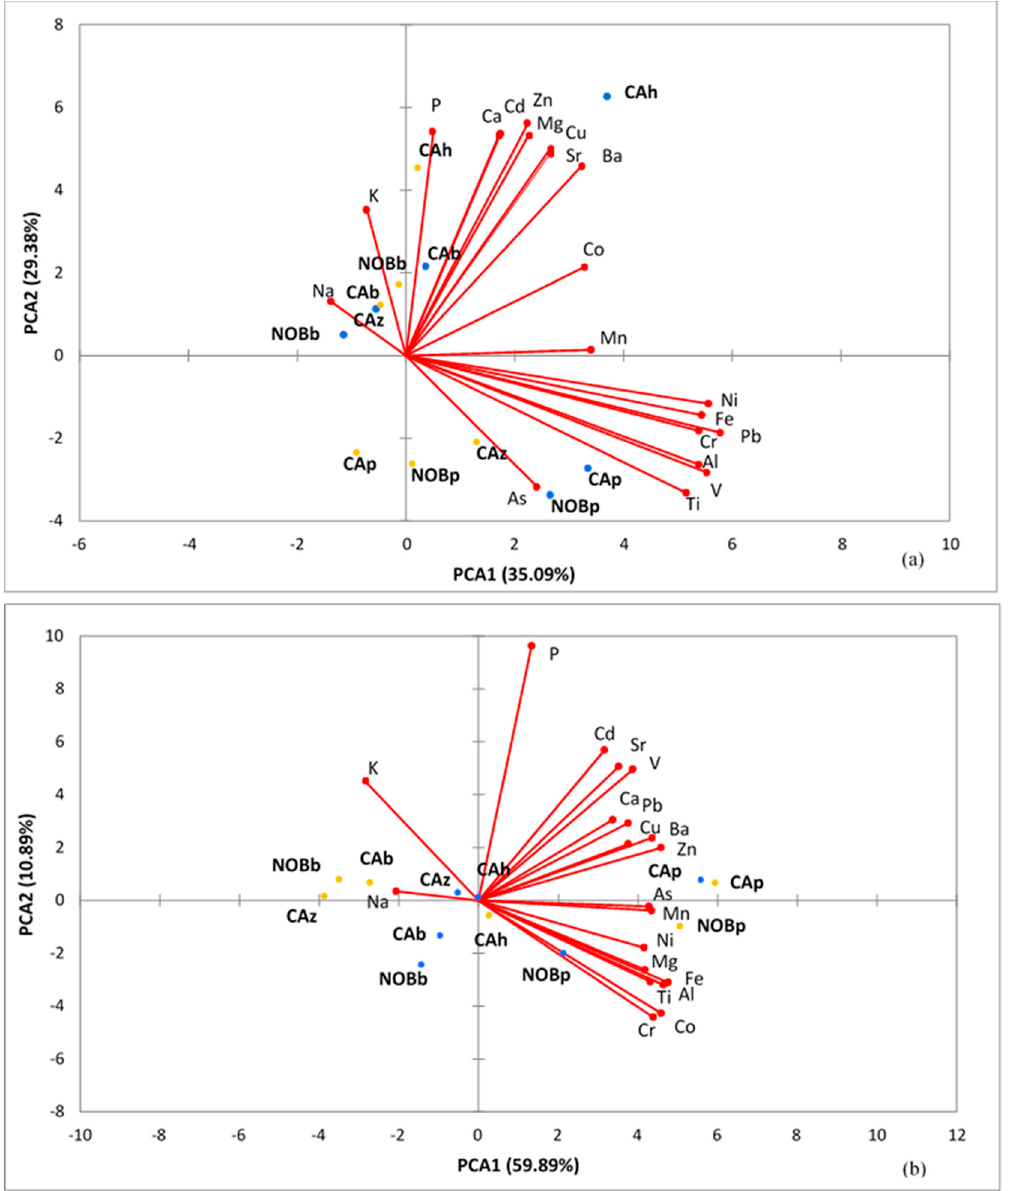
Figure 2. Score and loading plot from principal component analysis (PCA) (PC1 vs. PC2) on element concentration data of ( a ) epigeal and ( b ) hypogeal parts. NOB = plants grown in Nobile soil, CA = plants grown in Campana soil, yellow spot = addition of FW to the soil, blue spot = no addition of FW, p = Pteris vittata , b = Brassica juncea , h = Helianthus annuus , z = Zea mays .